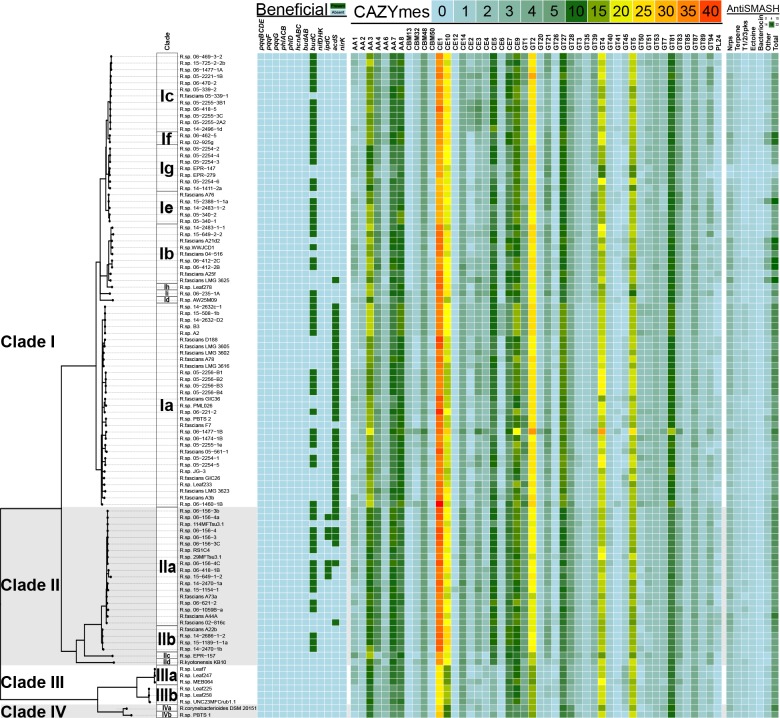
Heatmap of genes and functions enriched in clades of plant-associated Rhodococcus.Genes associated with plant-beneficial functions were used as queries in TBLASTN searches for homologs in Rhodococcus (green = presence [>40% identity, >70% length]; cyan = absence). For the CAZYmes, only the 48 most highly represented classes are shown. The key shows the number of homologs detected. Putative secondary metabolite biosynthetic clusters were identified using antiSMASH. The key shows the number of loci predicted for each category.